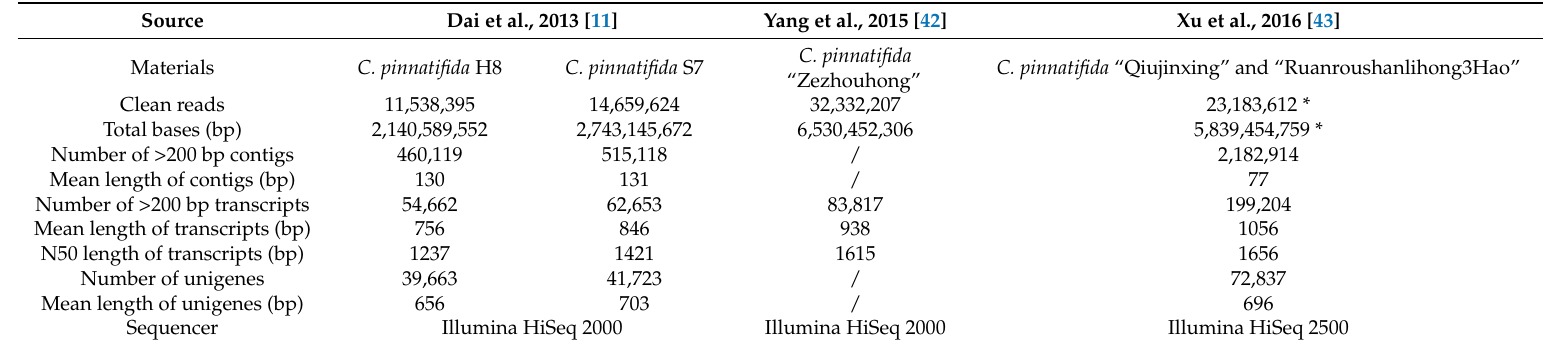
Table 3. General information of sequencing and assembly for three hawthorn transcriptomes.